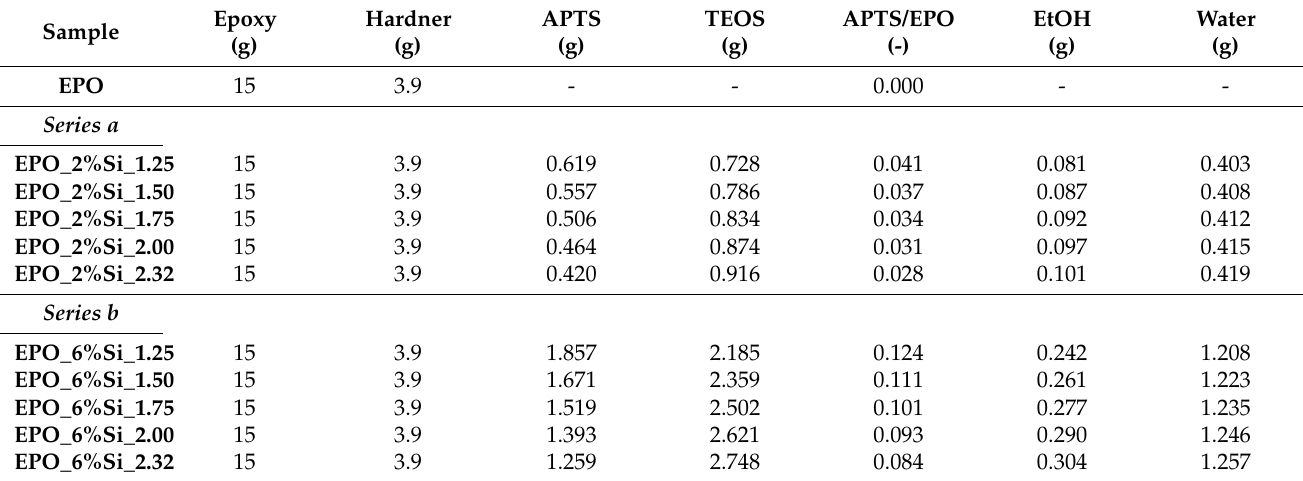
Table 1. Composition and codes of the investigated epoxy